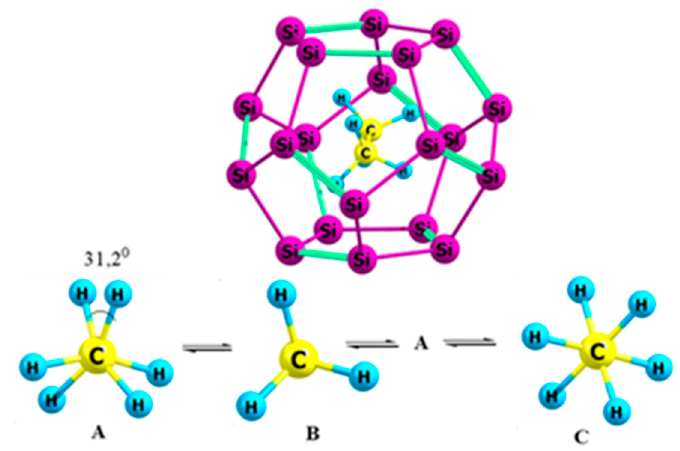
Figure 14. Conformational equilibrium of the guest molecule in cluster C 2 H 6 @Si 20 . Adapted with modification [195].